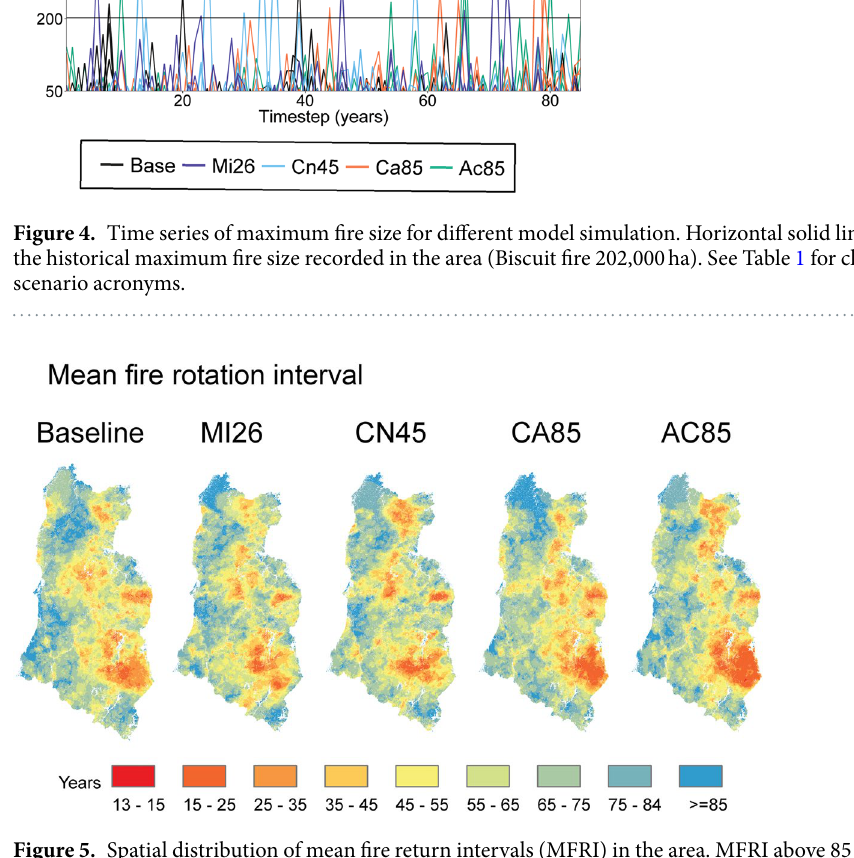
Figure 5. Spatial distribution of mean fire return intervals (MFRI) in the area. MFRI above 85 indicates that no fire was recorded in the area for the simulations analyzed. See Table 1 for climate change scenario acronyms. Maps were created using raster package v 2.3.40 in R 3.3.0